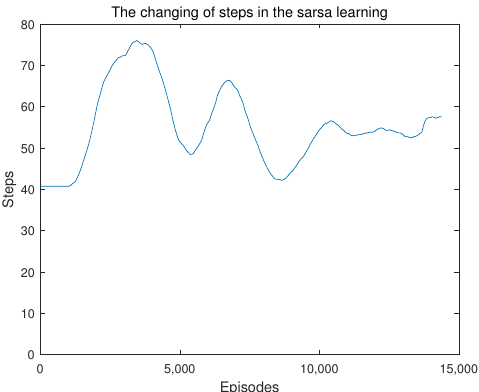
Figure 8. The number of steps for each episode in the policy